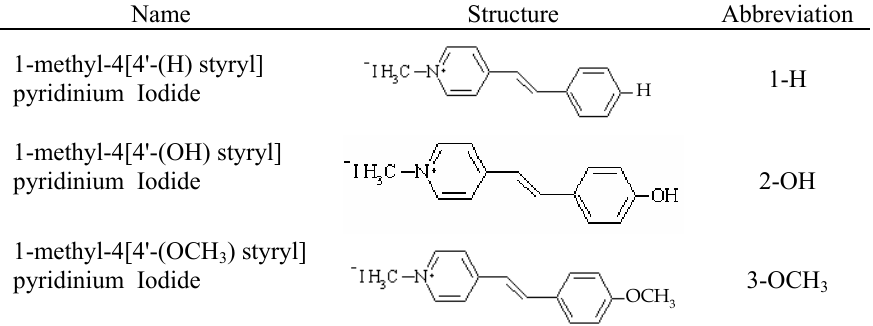
Table 2. The physical and chemical properties of Dowex 50WEX/H